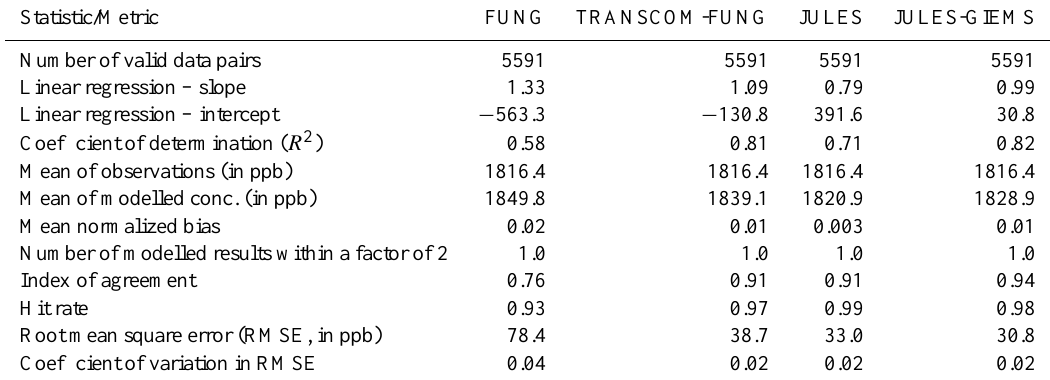
Table 1. Statistical outputs from the “global” analysis of the observed and modelled surface methane concentrations for the HadGEM2 runs (FUNG, TRANSCOM-FUNG, JULES and JULES-GIEMS) using valid co-located data from all monitoring sites.